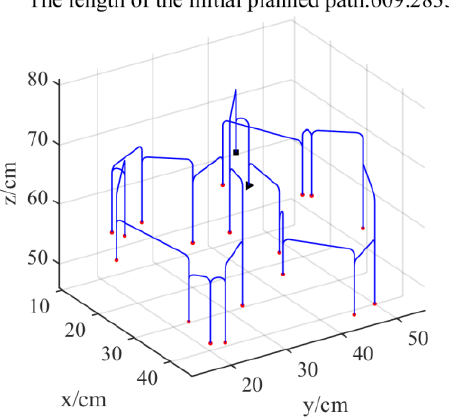
Figure 14. Optimal picking path from Initial path planning.